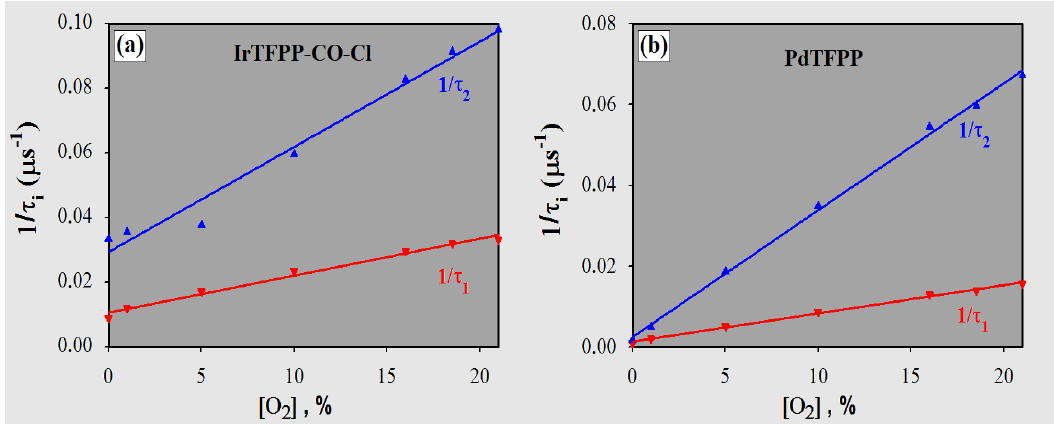
Figure 7. Reciprocals of τ 1 and τ 2 versus [O 2 ] for ( a ) IrTFPP-CO-Cl and ( b ) PdTFPP immobilized in the